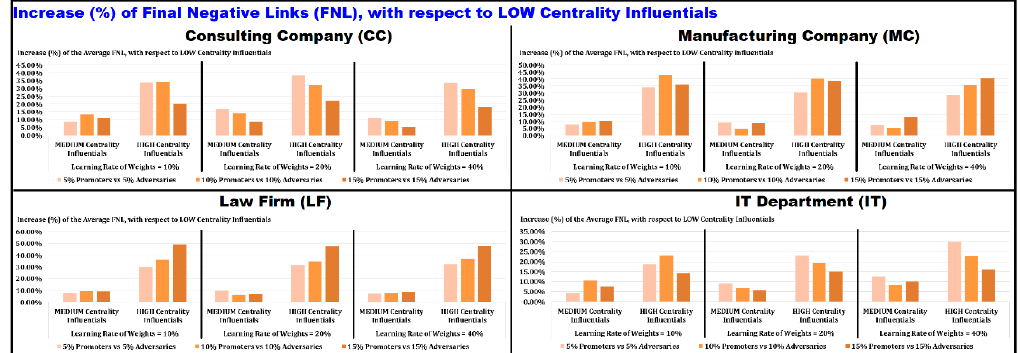
Figure 6. Relative Increase (%) of Final Negative Links (blue horizontal lines in Figure 4) for the selected values of centrality and learning rate (Table 3). The increase of Final Negative Links when promoters and adversaries increase from 5% to 10% is indicated in the left column. The right column (darker) shows the increase when promoters and adversaries increase from 5% to 15%.